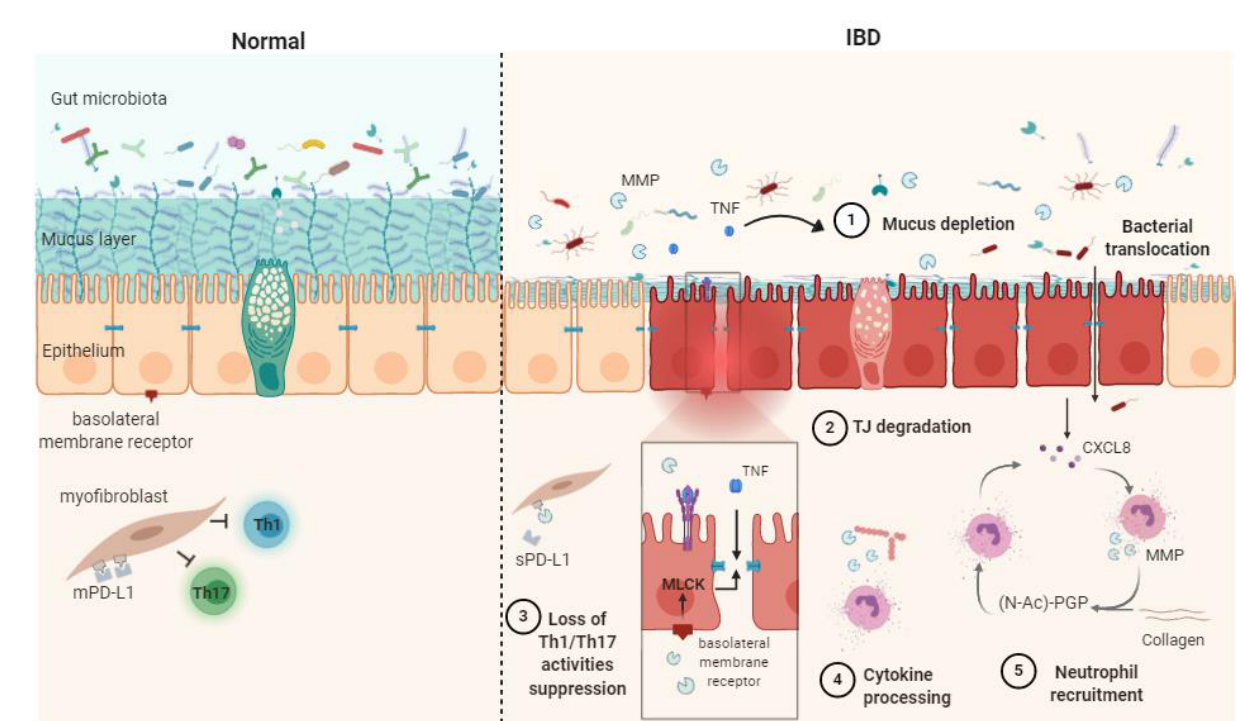
Figure 1. Schematic representation of matrix metalloproteases (MMPs) mechanisms of action in healthy contet ( Normal ) and in inflammatory bowel disease ( IBD ) pathophysiogenesis. The release of soluble TNF-α resulting from the shedding of membrane-bound TNF by MMPs causes mucus depletion ( 1 ) and tight-junction destabilization ( 2 ), leading to increased epithelial permeability and bacterial translocation. The abrogation of myofibroblast ability in suppressing Th1/Th17 occurs after the MMP processing of membrane-bound PD-L1 to produce soluble PD-L1 ( 3 ). Cytokine processing contributes to inflammation processes ( 4 ). PGP generation through collagen degradation by MMPs induces neutrophil transmigration and stimulates neutrophil MMP and CXCL8 secretion, therefore sustaining the inflammatory context ( 5 ). CXCL8: (C-X-C motif) ligand 8, MLCK: myosin light-chain kinase, PD-L1: programmed death-ligand 1, mPD-L1: membrane-bound PD-L1, sPD-L1: soluble PD-L1, (N-Ac)-PGP: (N-acetyl)-proline-glycine-proline, TJ: tight junction, TNF: tumor necrosis factor α